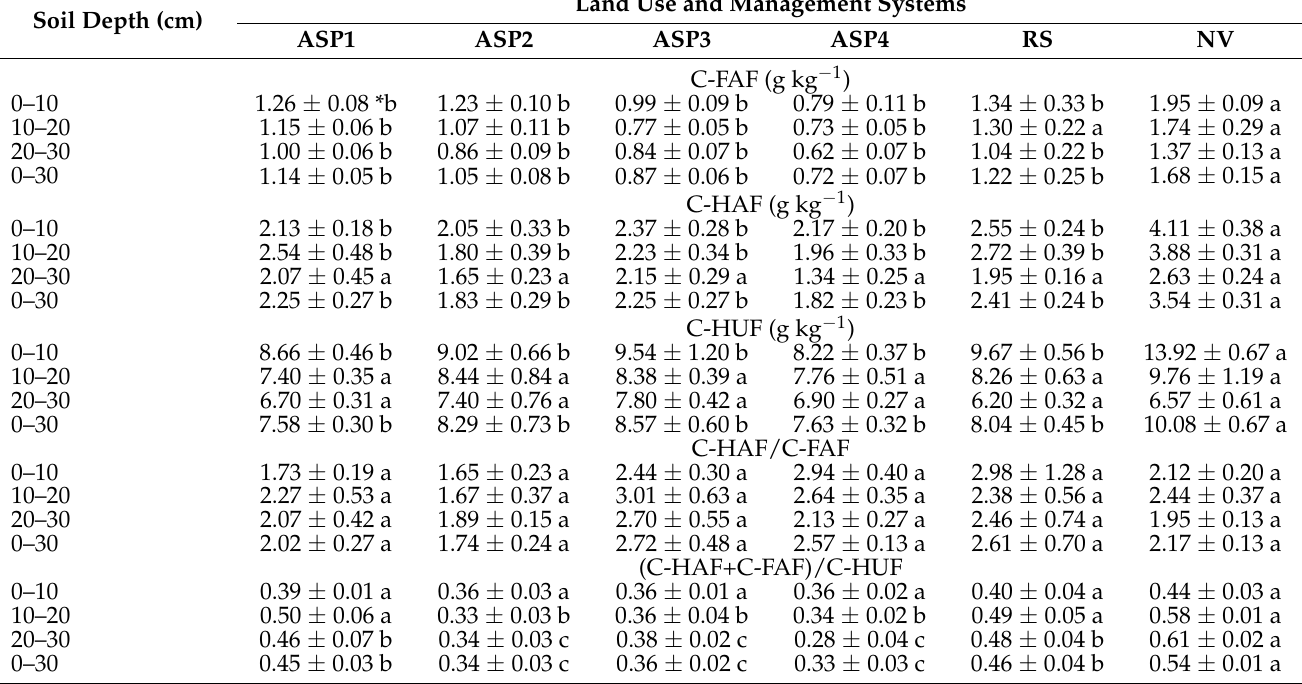
Means followed by the same letter for the same line (horizontal) or depth did not differ by the Scott-Knott test ( p < 0.05). * Mean value ± standard error of the mean. Table 2. Carbon contents in the humic fractions of SOM under different land use and management systems at Bonsucesso farm in Minas Gerais State, Brazil. Systems: E. camaldulensis × E. tereticornis hybrid intercropped with buffel grass using the arrangements 2 × 3 + 10 m (ASP1) and 2 × 3 + 15 m (ASP2); E. urophylla × E. grandis hybrid intercropped with buffel grass using the arrangements 2 × 3 + 10 m (ASP3) and 2 × 3 + 15 m (ASP4); Regeneration stratum (RS); and native vegetation